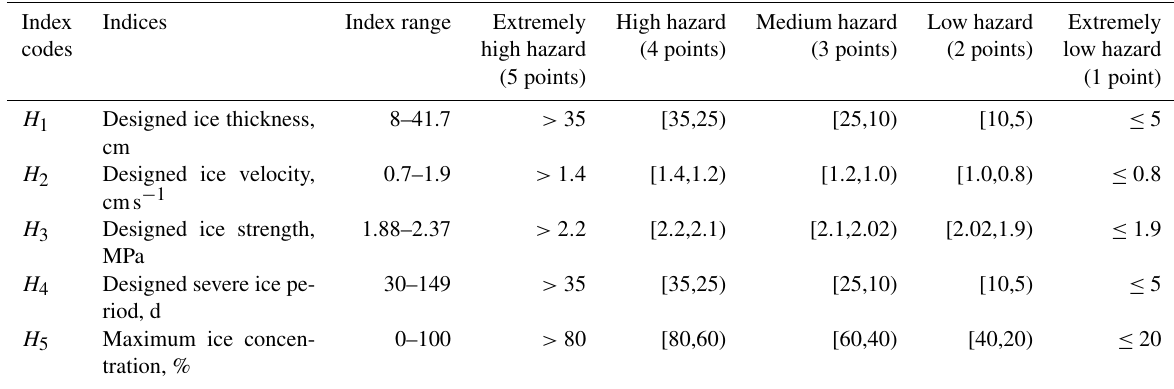
Table 2. Grading of sea ice hazard